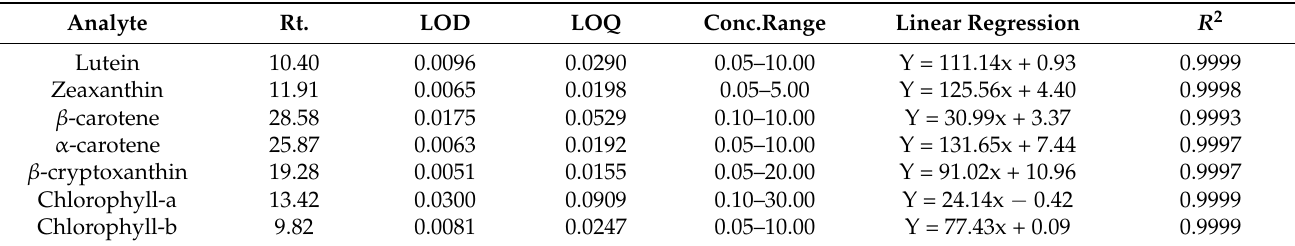
Table 1. Retention time (min), limit of detection ( µ g mL − 1 ), limit of quantification ( µ g mL − 1 ), concentration range ( µ g mL − 1 ), and regression